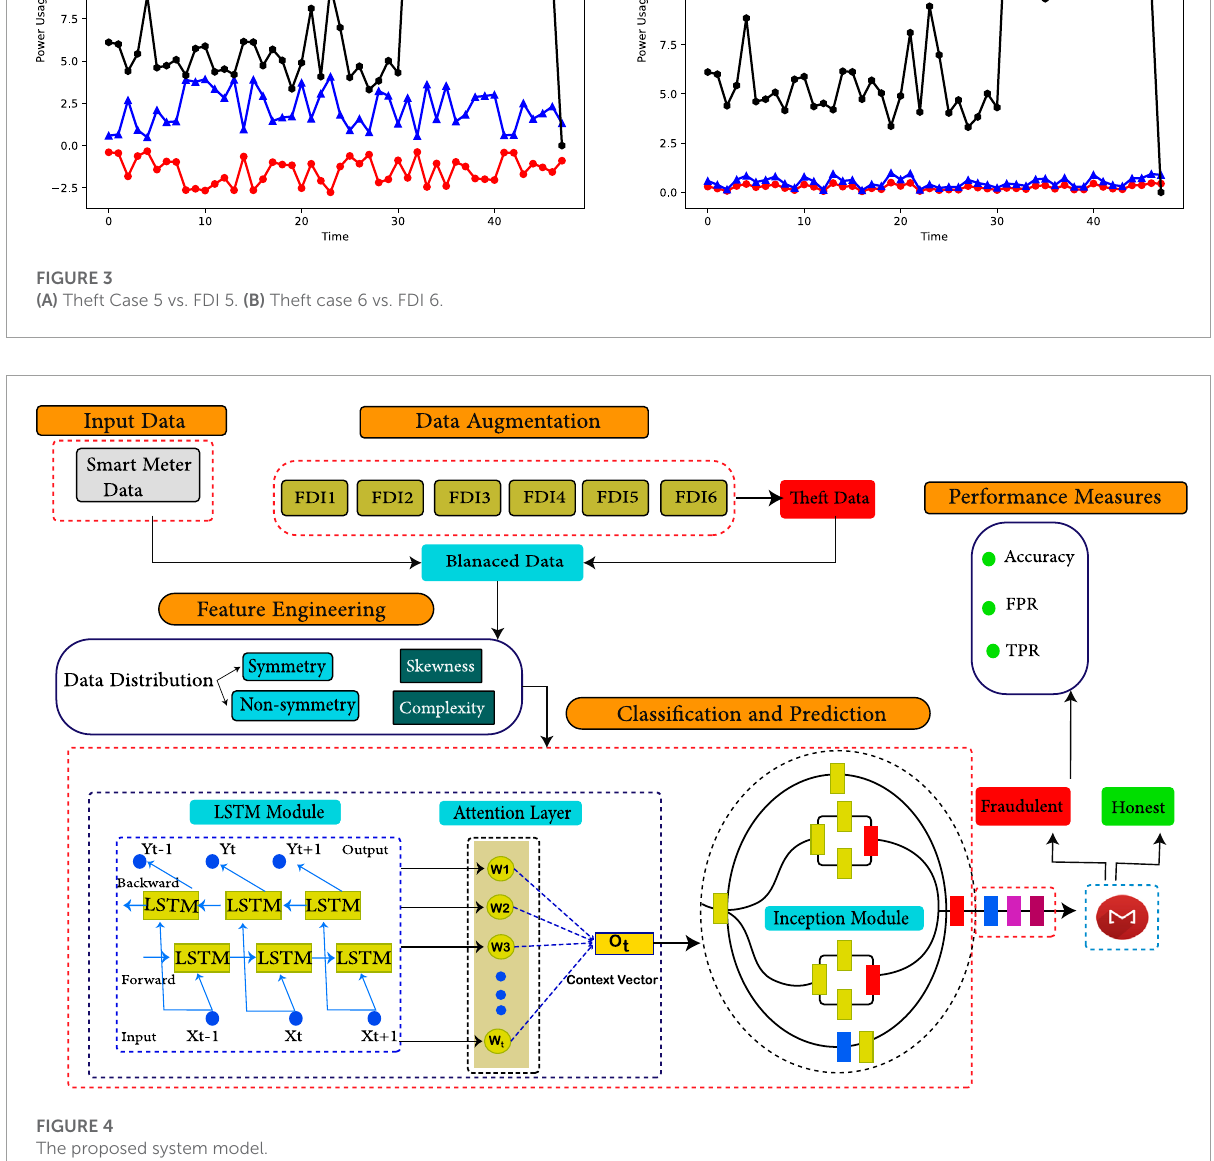
FIGURE 4 The proposed system